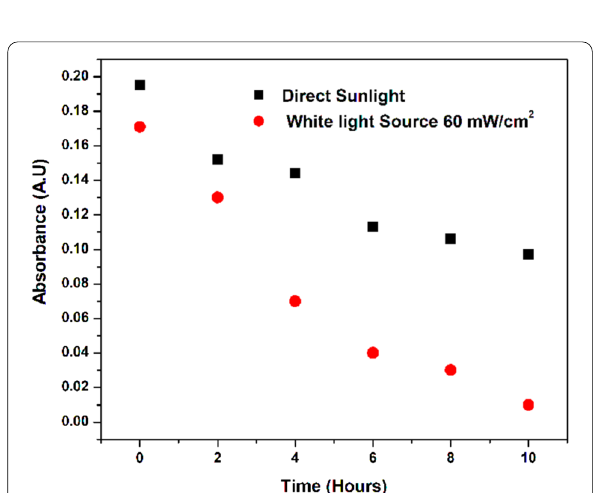
Fig. 9 Comparison of peak absorbance as a function of time for 20 µmol/L dye solution mixed with sample 1S5 under direct sunlight illumination and under white light source of intensity 60 mW/cm